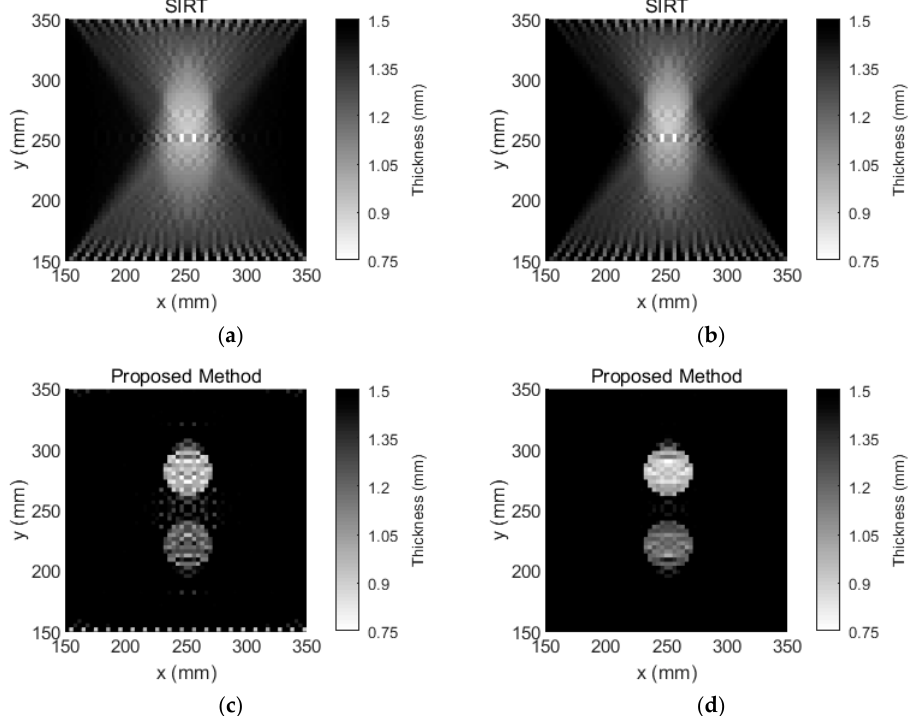
Figure 8. Tomographic reconstruction images for a 1.5-mm-thick aluminum plate with 40-mm-diameter circular flat-bottomed holes. Their thickness losses are 50% and 30% within the flaws. ( a ) The tomographic reconstruction image that is obtained via SIRT without temperature compensation, ( b ) the tomographic reconstruction image that is obtained via SIRT with temperature compensation, ( c ) the tomographic reconstruction image that is obtained via our method without temperature compensation, and ( d ) the tomographic reconstruction image that is obtained via our method with temperature compensation.